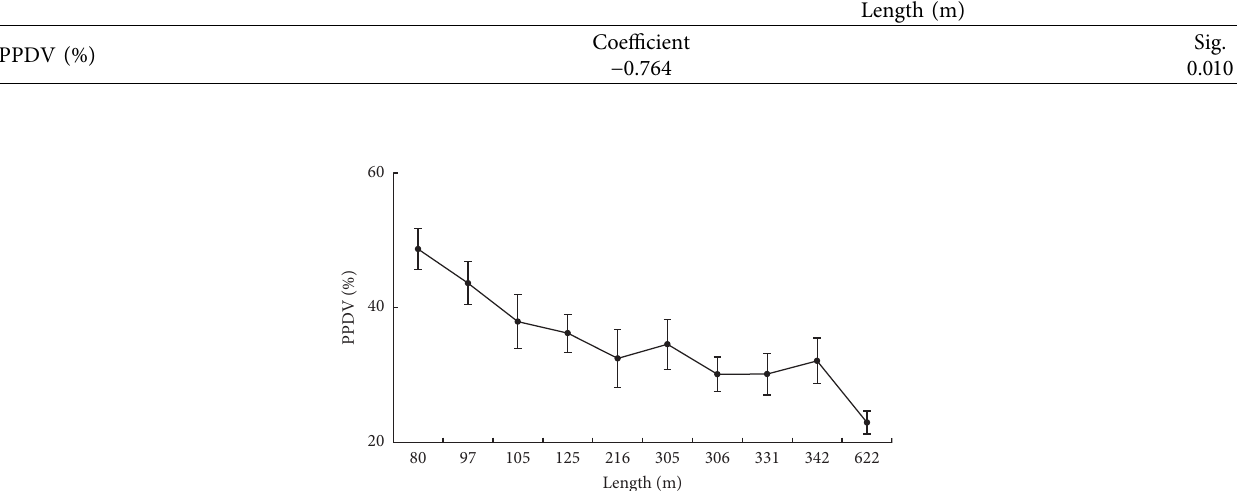
C ) and PPDV. Length (m)